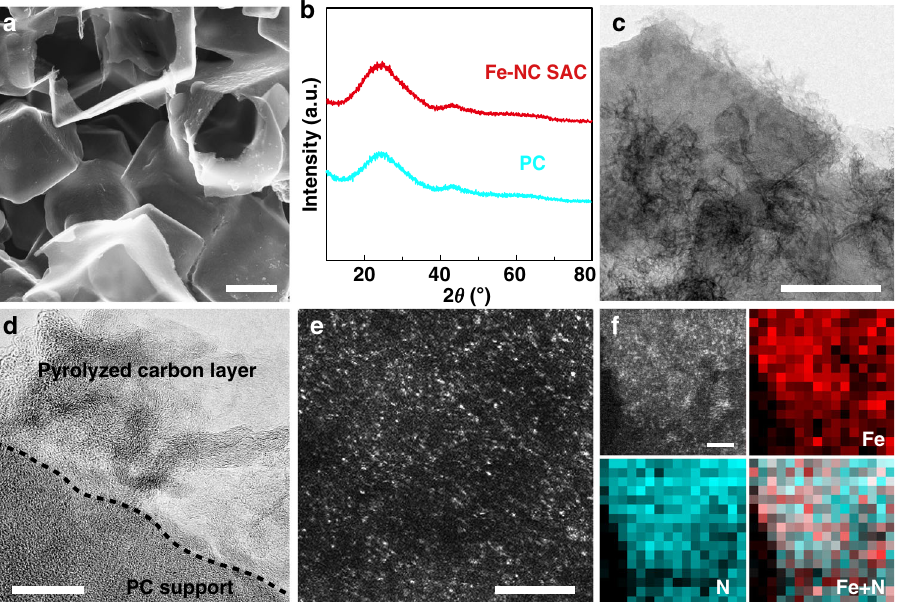
Fig. 2 Structural characterizations of PC support and Fe – NC SAC. a SEM image of PC support. b XRD patterns of PC and Fe – NC SAC. c TEM, d , HRTEM, e , HAADF – STEM images of Fe – NC SAC. f HAADF – STEM image and EELS mapping images of Fe, N, and overlaid Fe and N on Fe – NC SAC. Scale bars, 1 μ m ( a ); 200 nm ( c ); 20 nm ( d ); 3 nm ( e ); 2 nm ( f